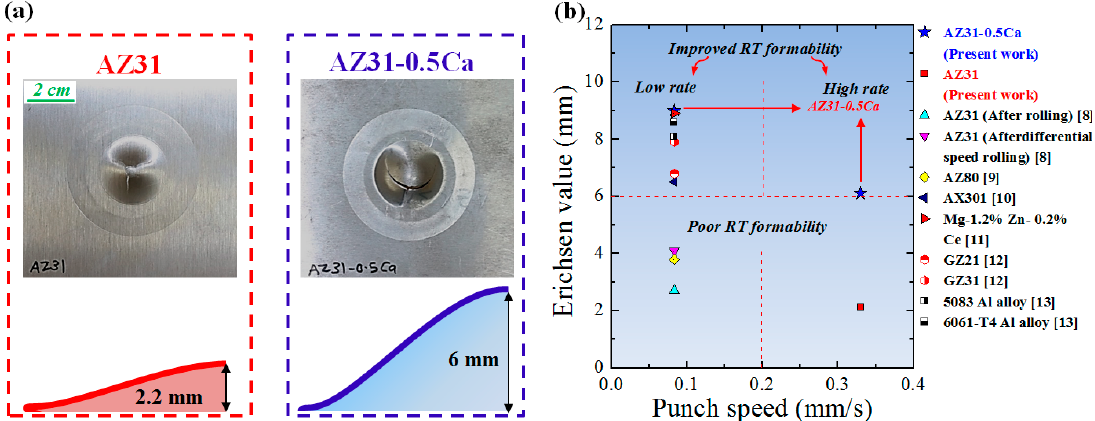
Figure 1. ( a ) Side views taken from the AZ31 and AZ31-0.5Ca alloy sheets after Erichsen test; ( b ) Comparison between Erichsen values of the AZ31-0.5Ca alloy studied in the present work with some other Mg and Al alloys.